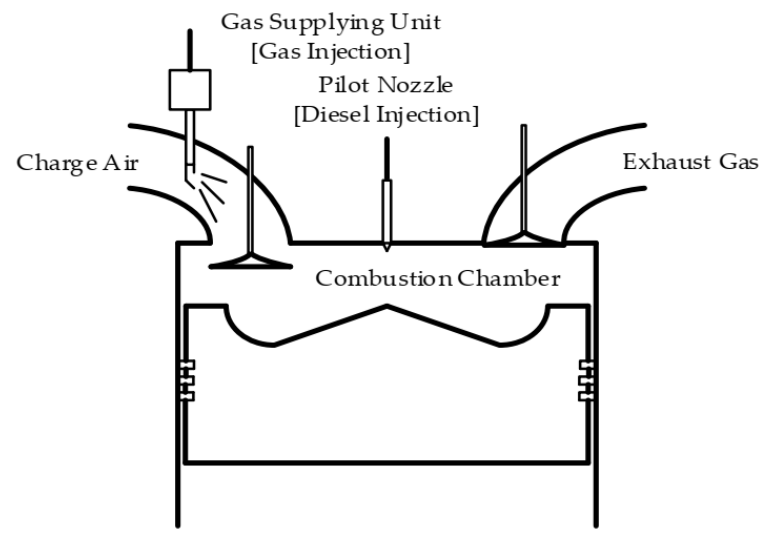
Figure 1. The principle schematic of the simulated engine. The quarter-cut 3D models of the piston and the pilot fuel nozzle are shown in Figure 2. The piston surface is an ω -type shape. The pilot fuel nozzle has 12 identical holes with an injection angle of 155 degrees. Specifications of the simulated engine are shown in Table 1. The engine has six cylinders with two intake valves and two exhaust valves per cylinder. The cylinder diameters and piston stroke of the engine are 350 and 400 mm, respectively.